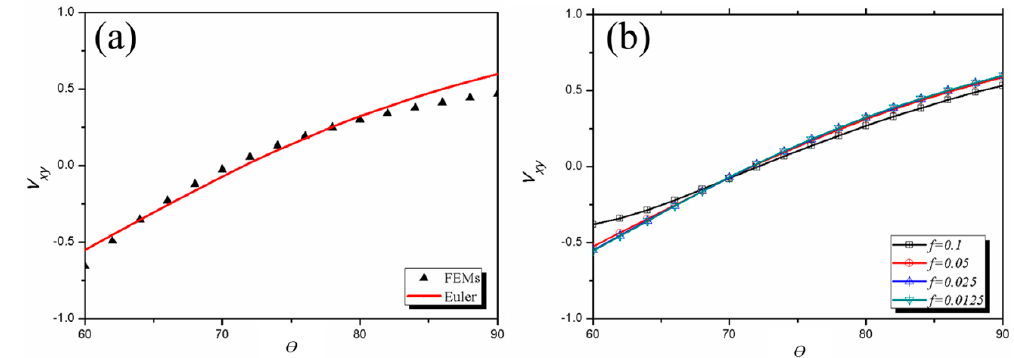
Figure 3. Poisson’s ratio calculated for the star structure versus the angle θ ( a ) using the finite element method (FEM) and Euler beam model with f = 0.025 and ( b ) at different slenderness ratios f .